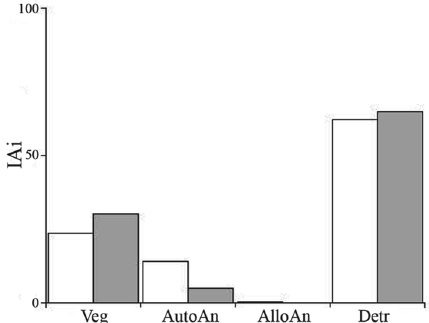
Fig. 2. Comparison of alimentary index (IA category consumed by Phalloceros anisophallos from córrego Andorinha (Ilha Grande, Rio de Janeiro) during the rainy (white bars) and dry (grey bars) seasons. Alg = autochthonous algae, AutoAn = autochthonous animal, AlloAn = allochthonous animal and Detr =